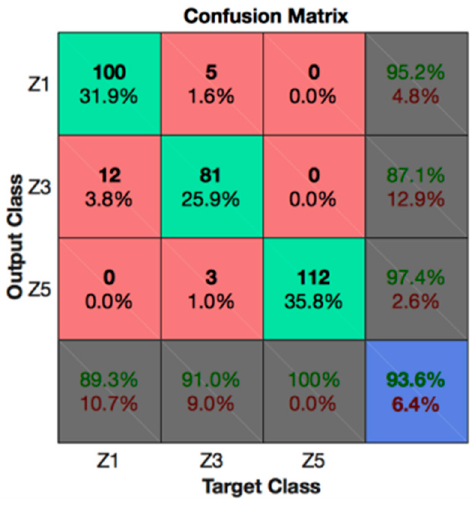
Figure 5. Confusion Matrix for Z_135 dataset with CGRU model.